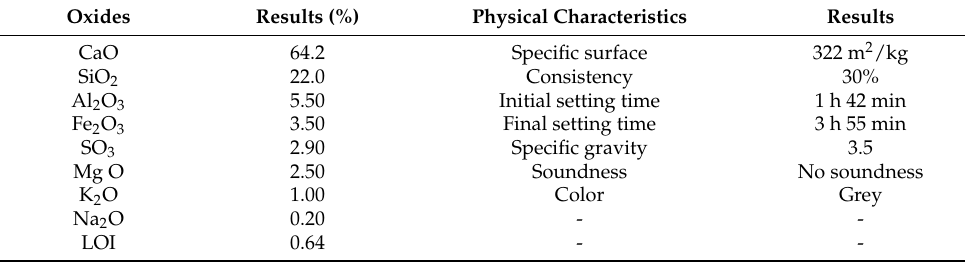
Table 1. The general characteristics of type II OPC used in the